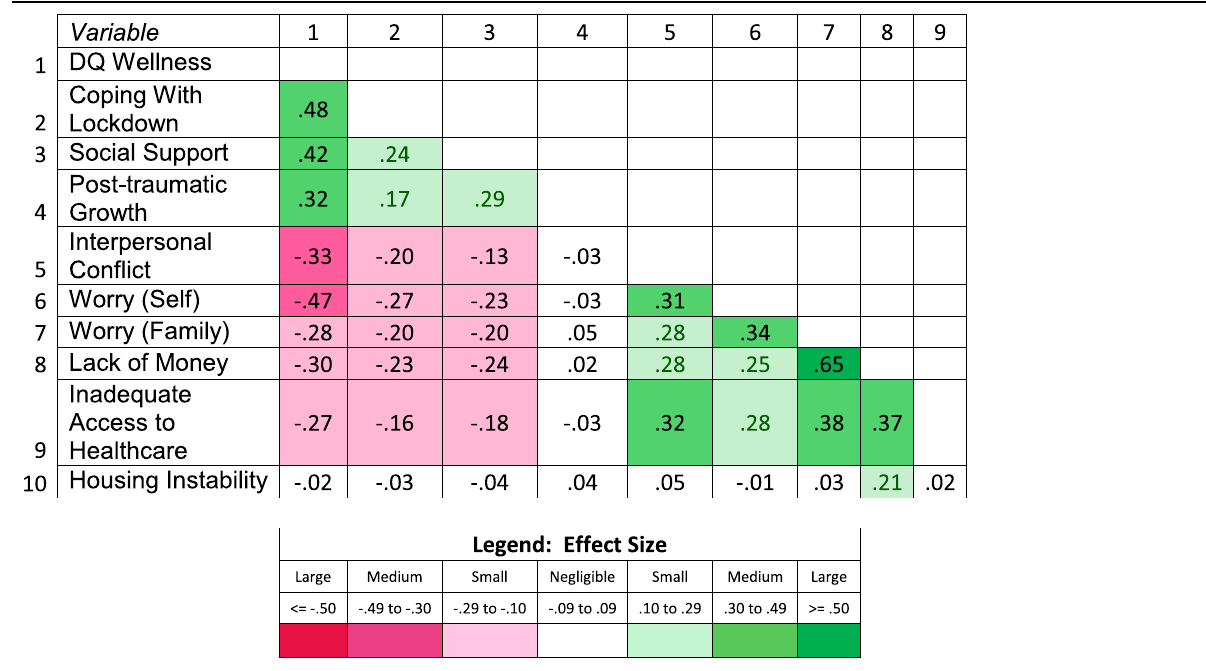
file 1: Table 3), box-and-whisker plots and bar charts